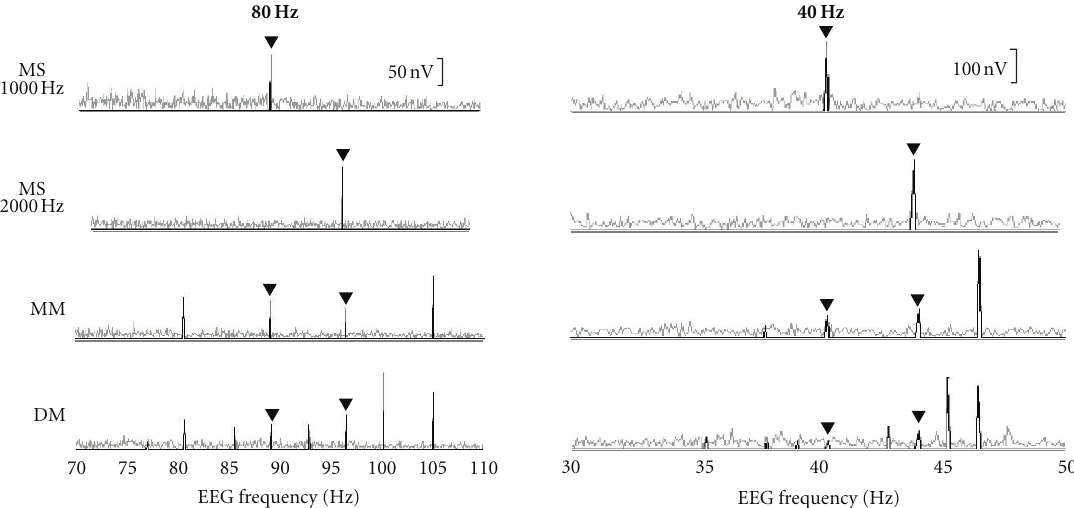
Figure 1: Representative normal-hearing subject’s ASSR amplitude spectra in the monotic single (MS), monotic multiple (MM), and dichotic multiple (DM) stimulus conditions. Filled triangles indicate response to 1000 and 2000 Hz